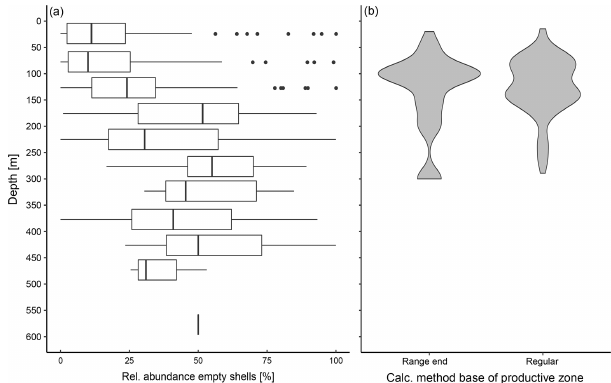
Figure 3. (a) Vertical profile of relative abundance of empty shells at all stations of the study in which empty and filled shells were distinguished. The boxes represent the interquartile range (IQR) of the relative abundance at the given depth, and the vertical bar rep- resents the median. Outliers, shown as points, are values beyond 1.5 × IQR of each site of the box, and lines represent the range within 1.5 × IQR. The line at 600m depth represents the abundance of empty shells in one single sample, as sampling in all other sta- tions did not reach to that depth. (b) Range of the base of the produc- tive zone (BPZ), divided by the way they were determined: “range end” shows all samples in which the maximum depth of the net of the transition zone was defined as the BPZ, while “regular” shows all samples in which the equation from Lonˇcari´c et al. (2006) to estimate BPZ could be applied, as described in Sect.